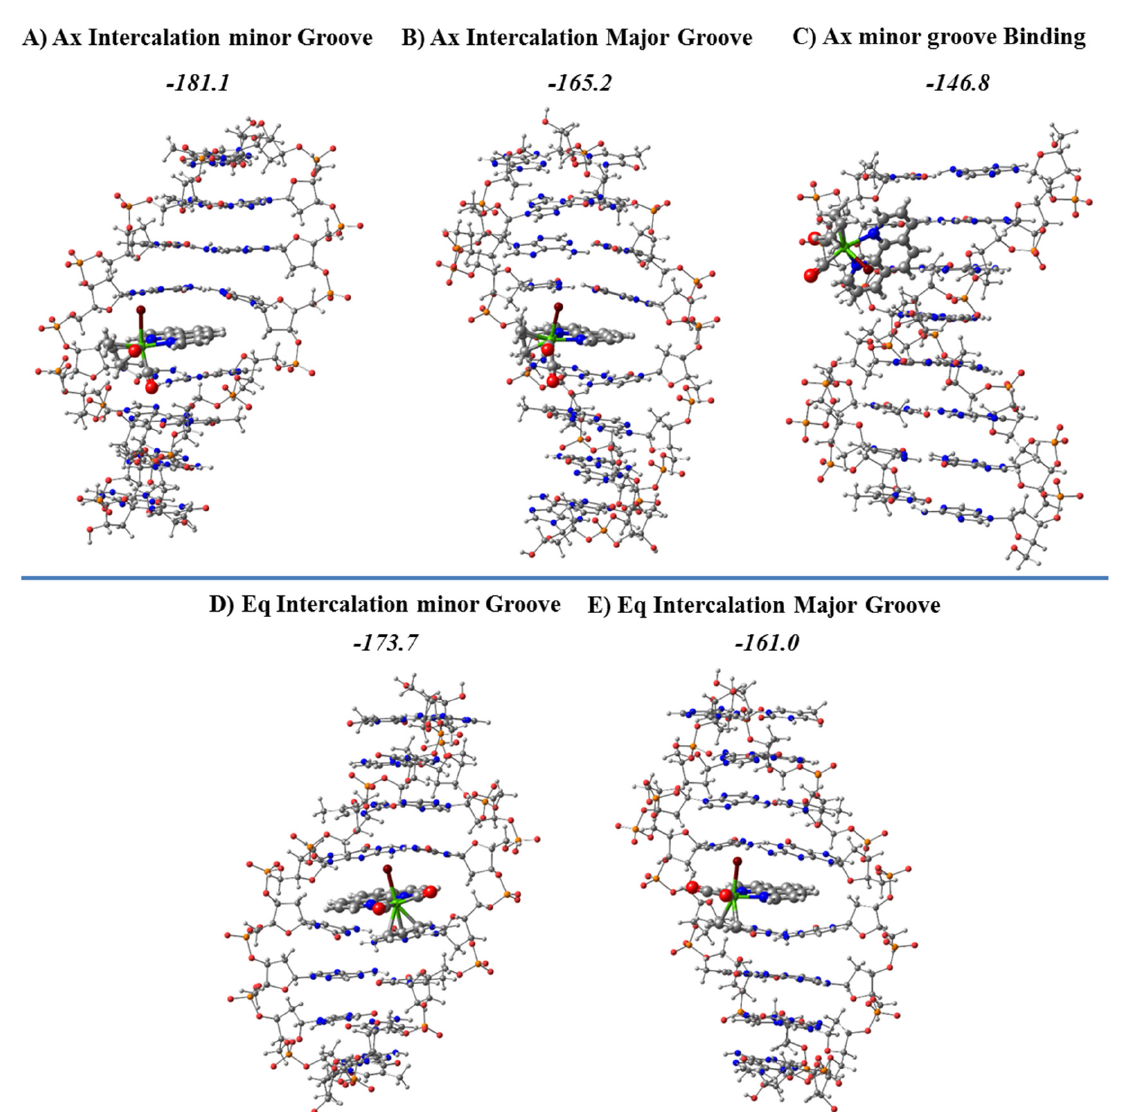
Figure 22. Most stable optimized structures for the intercalation of the Ax and Eq isomers of the [Mo( η 3 - C 3 H 5 )Br(CO) 2 (phen)] metal complex in the d(AGACGTCT) 2 dDNA octamer at the LMKLL/DZ2P level. For the Ax isomer the most stable structure of the groove binding mode of interaction is also shown. Formation energies in kcal mol − 1 .